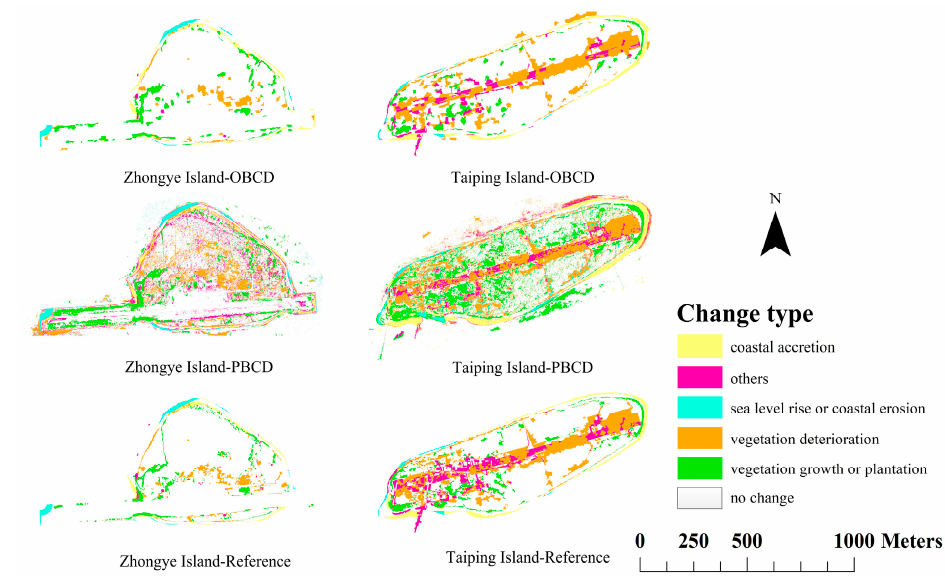
Figure 4. Change detection maps and reference maps of Zhongye Island and Taiping Island.